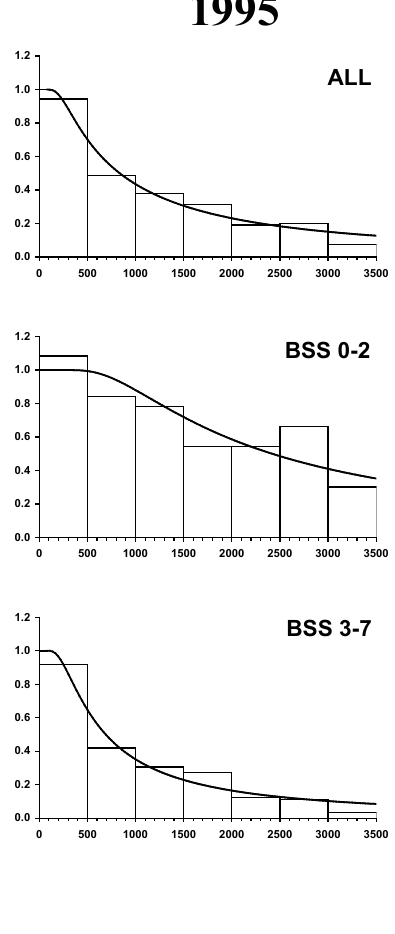
Fig. 5 . Distribution of perpendicular distance (m) to sightings made onboard the Icelandic and Faroese vessels in 1995 and 2001 stratified by vessel in 2001 and 2 categories of Beaufort Sea State (BSS) in 1995. For vessel identity see Table